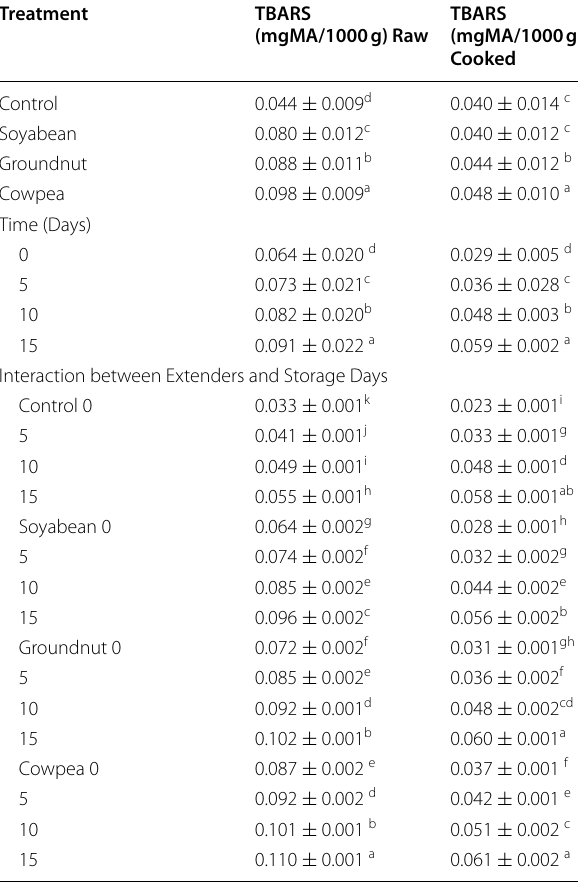
Table 7 Lipid oxidation of raw and cooked broiler chicken nugget extended with legume